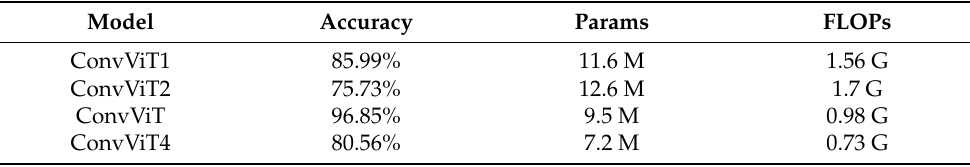
Table 5. Comparison of specific experimental results of different